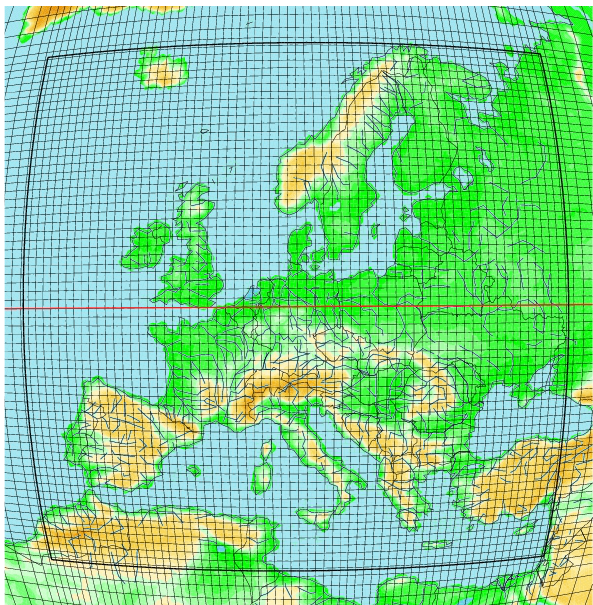
Figure 1. GEM-AQ computational domain configuration. Global variable grid with rotated equator (red line). Thicker black line bor- ders the central region with the resolution of 0 . 2 ◦ × 0 . 2 ◦ .